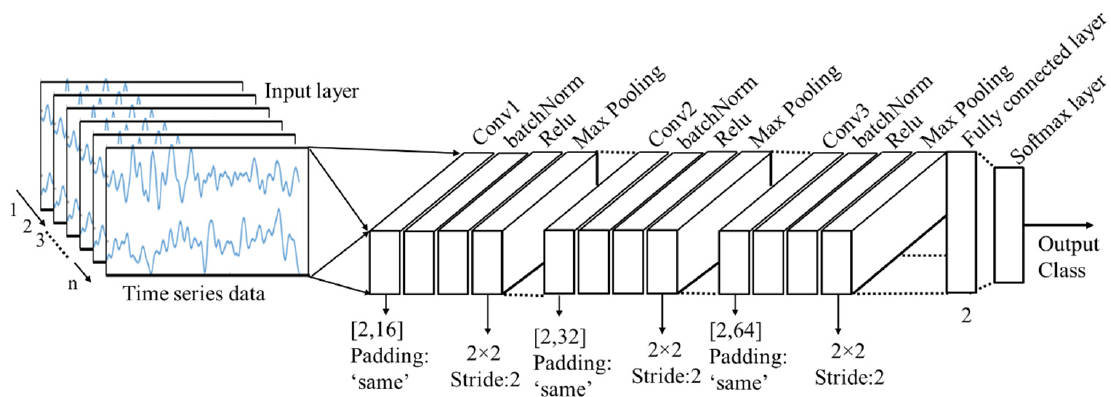
Figure 5. CNN architecture for the time series classification.